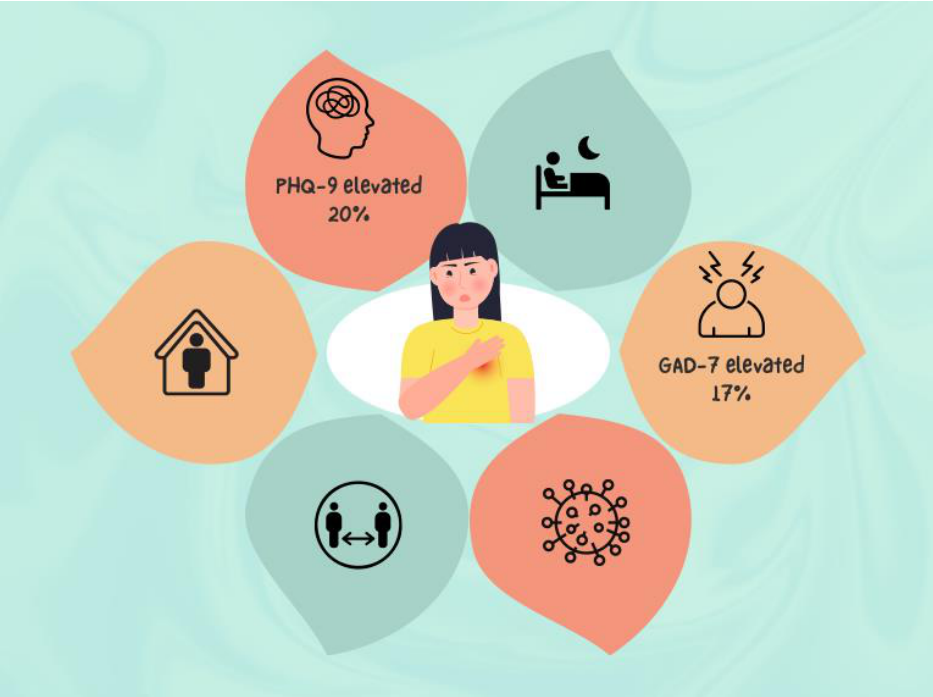
Figure 1. Early in the COVID-19 pandemic in China, older adults were optimistic and highly compliant with prevention and control.